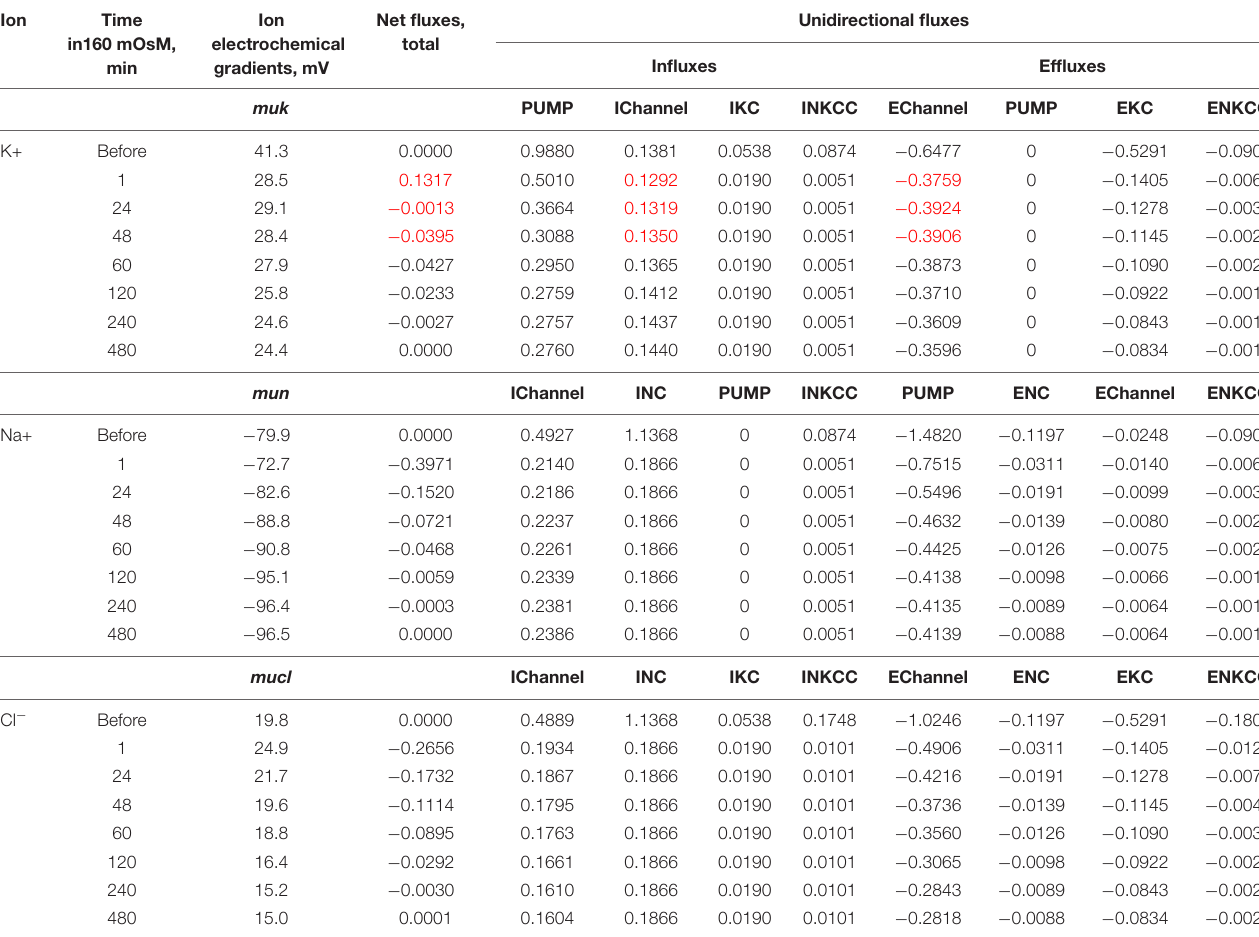
TABLE 4 | Dynamics of the net and unidirectional fluxes of K + , Na + , and Cl − during transition from a normal medium of 310 mOsm to the hypoosmolar solution of 160 mOsm, calculated for the system with the complete set of cotransporters at the unchanged-over-time parameters as in U937 cells equilibrated with standard RPMI medium.